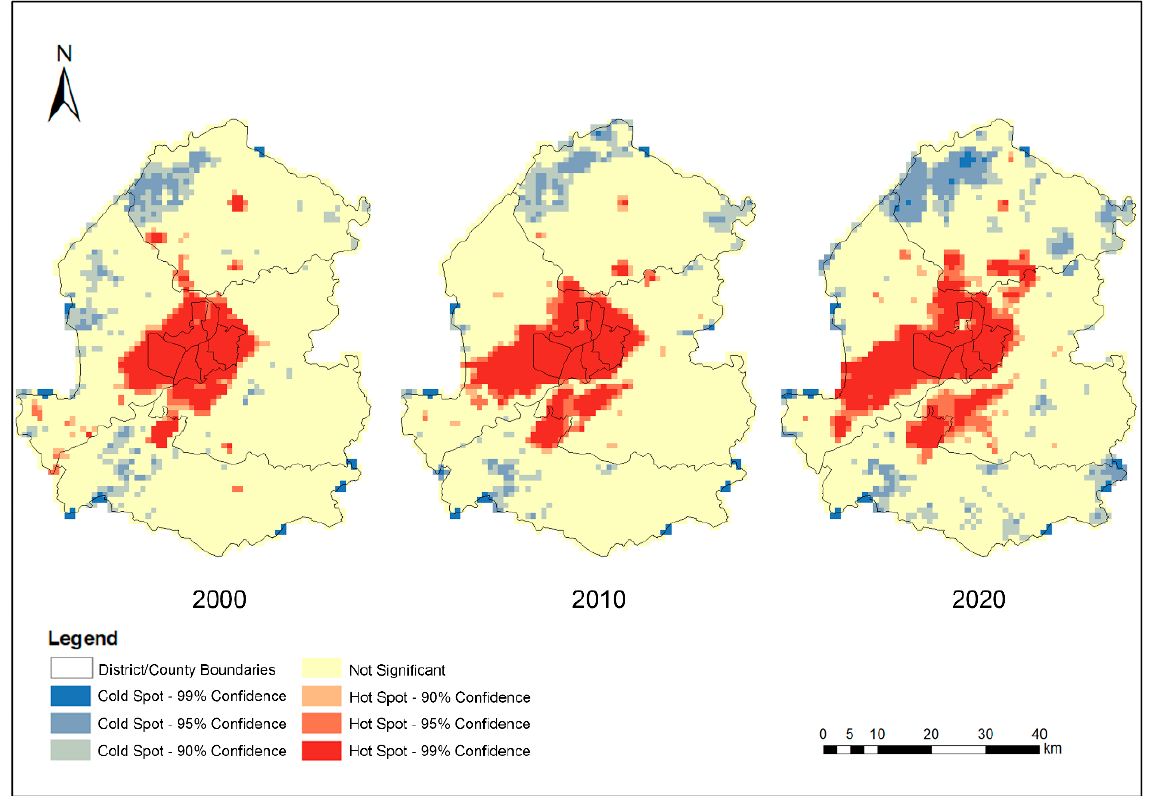
Figure 5. Statistical results of hotspot analysis (Getis–Ord Gi*).